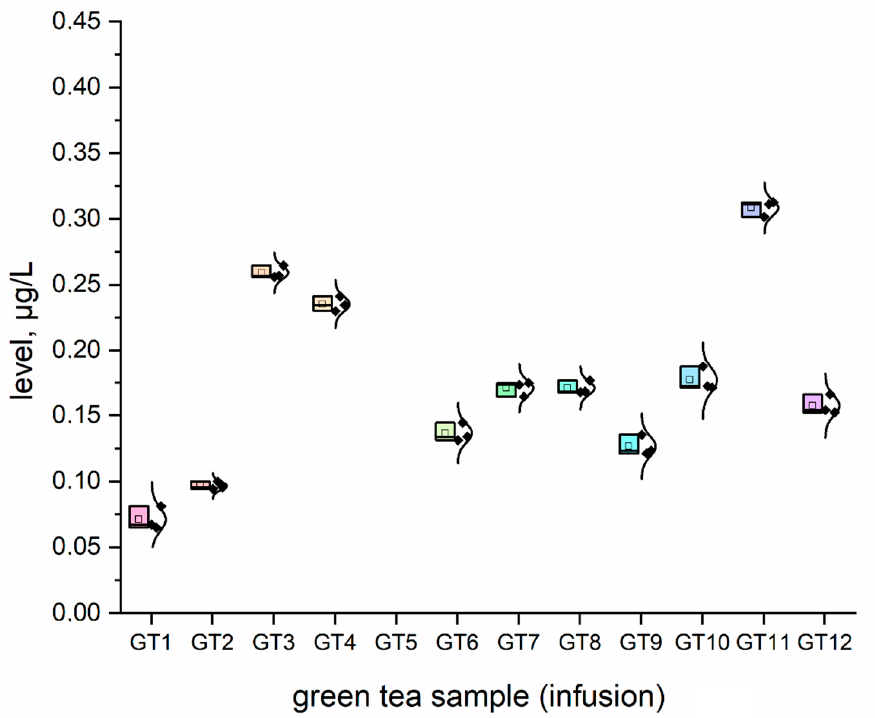
Figure 6. The plot as a box chart, with a normal distribution curve for Se concentration ( μ g/L) in analysed green tea samples (infusions; GT1–GT12). The colors indicate the results for the individual tested samples, the symbol indicates the standard deviation.